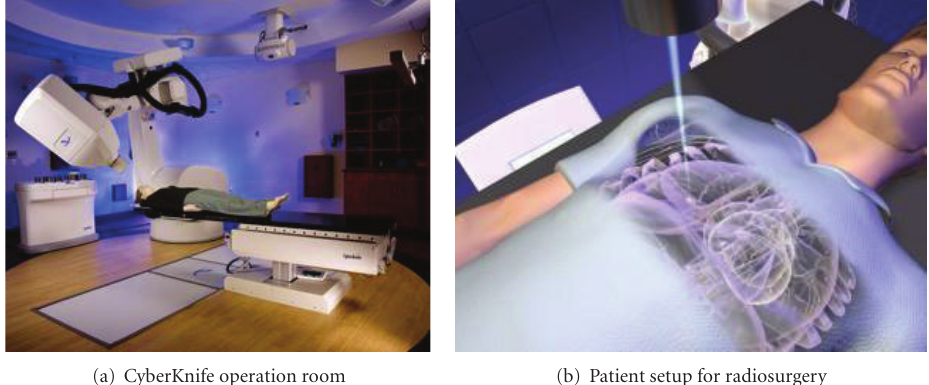
Figure 7: (a) Patient setup for radiosurgery with the use of fine and high-power radiation beams delivered by a miniature linear accelerator and positioned by a robotically controlled arm in CyberKnife by Accuray Inc. [15, 16]. (b) Cyberknife schematic for non-invasive image- guided